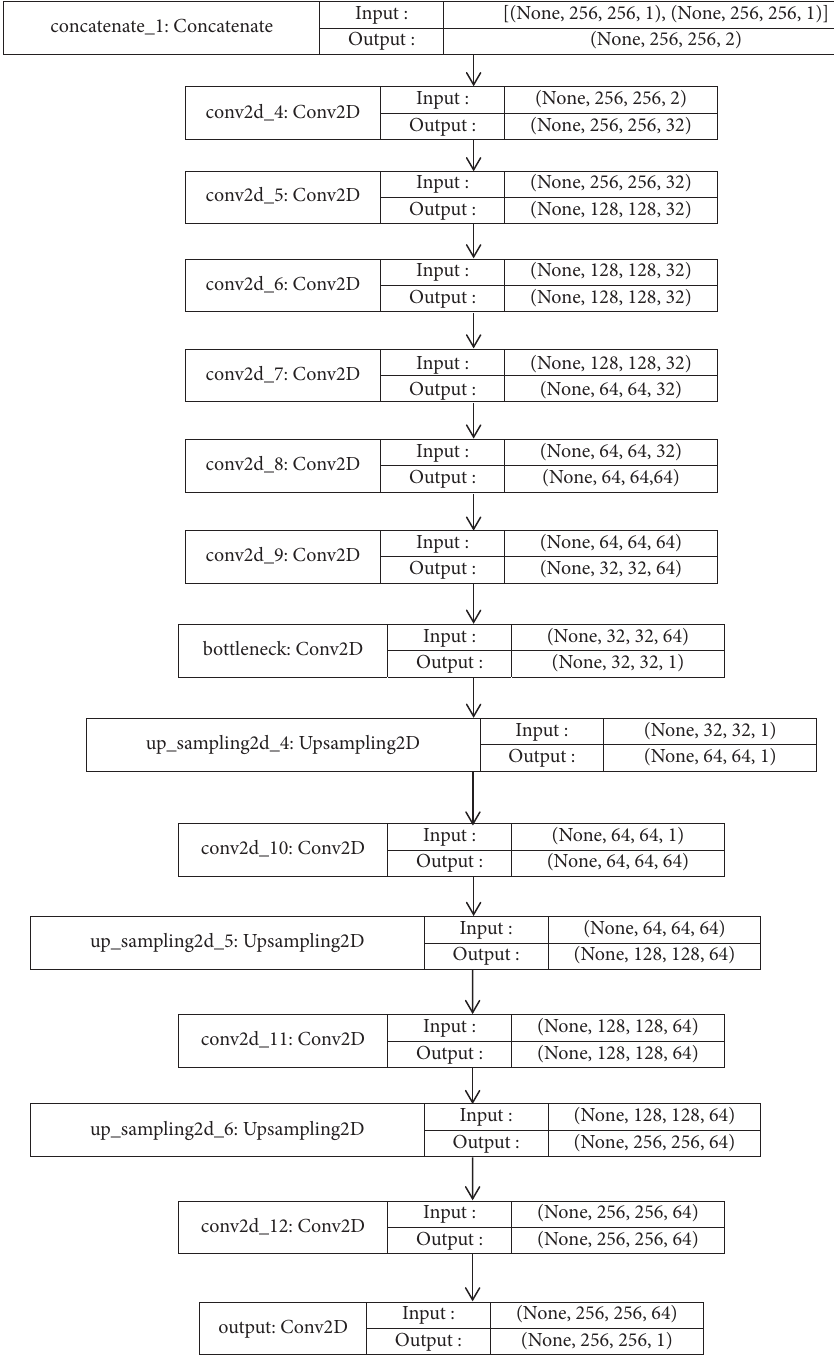
Figure 2: Structure of the proposed autoencoder neural